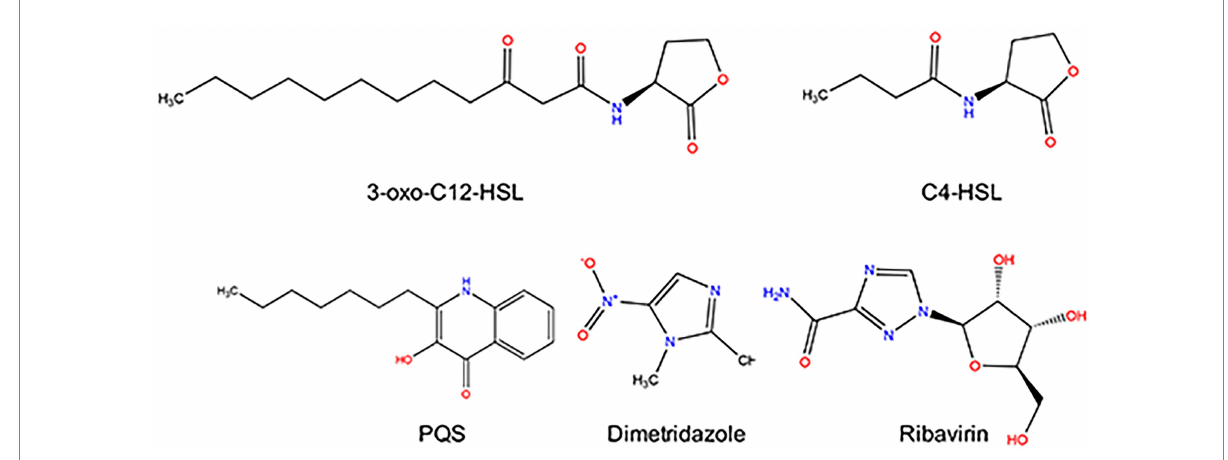
(Figure 4A; Supplementary Dataset 1). KEGG